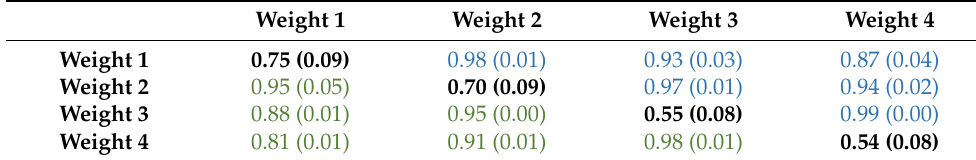
Table 3. Heritability (h 2 ) and genetic/phenotypic correlation for body weight using pedigree rela- tionship matrix (PRM). Heritability is on the diagonal in bold; genetic and phenotypic correlations are above the diagonal (in blue) and below (in green), respectively. Standard errors are illustrated in the parentheses.